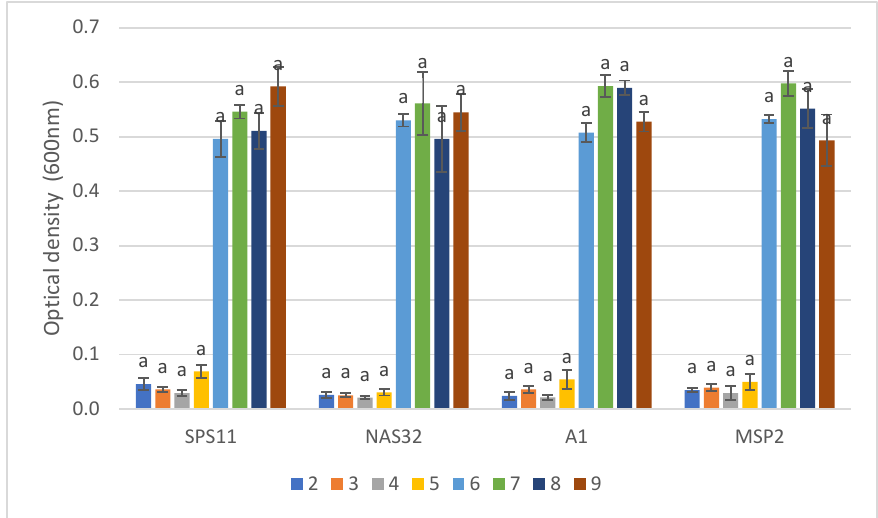
Figure 6. The growth of MSP2 and its constituent single-strain probiotics (SSPs) at different pH levels (2–9). Values are presented as mean ± SE ( n = 3). Significant differences are indicated by different letters ( p <